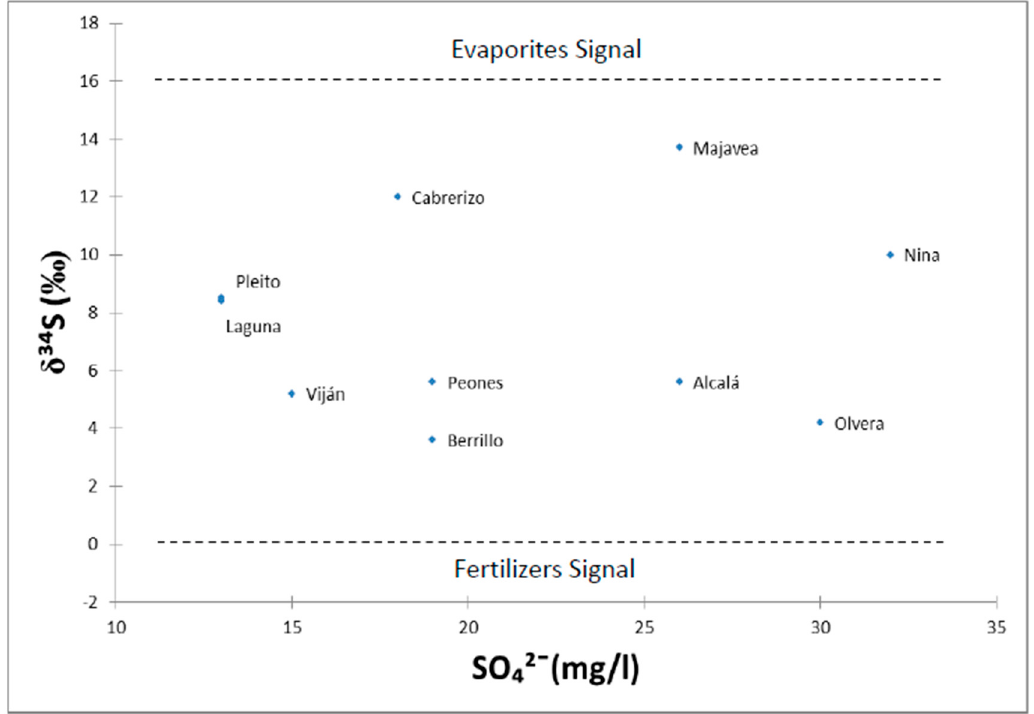
Figure 10. Representation of sulfate concentration (mg/L) versus δ 34 S values. Source: Values of the isotopic signal corresponding to evaporites and fertilizer and manure adopted from [18].